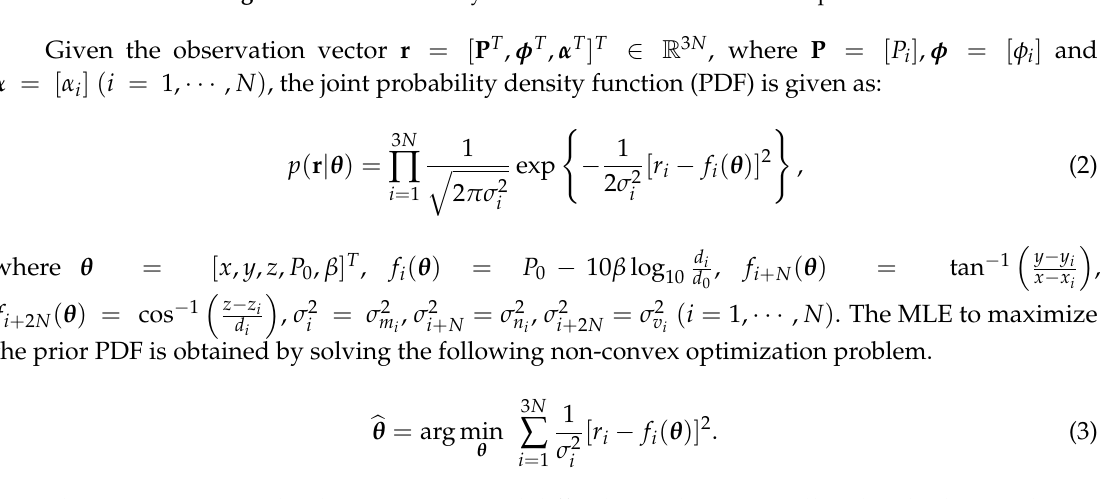
Figure 1. Illustration of hybrid RSS-AoA localization in 3D